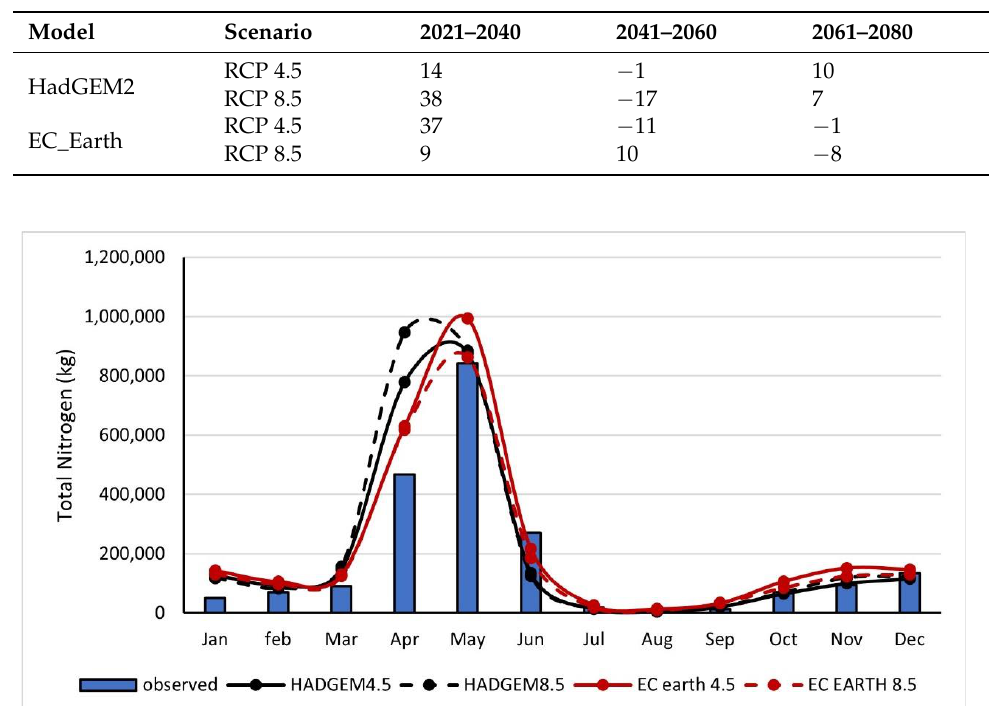
Figure 8. Average monthly total nitrogen (TN) load for climate scenarios RCP 4.5 and RCP 8.5 of GCM climate models, HadGEM2 and EC-Earth .